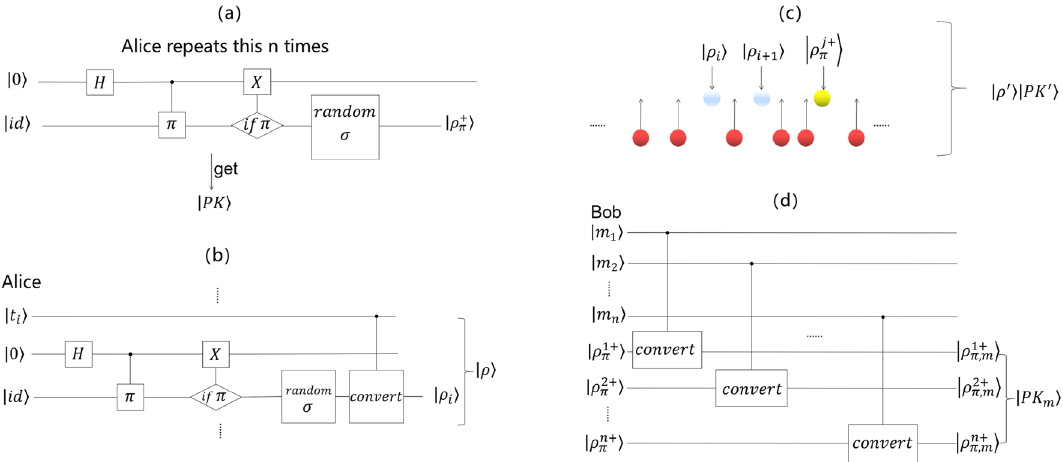
Figure 4. ( a ) Alice repeats the ρ + π ( n ) generation algorithm n times with her private key to obtain the public key, where the H, “if π ” and “random σ ” operations are the same as the operations in Fig. 3. ( b ) Alice uses this quantum circuit to obtain encrypted sequence perform the “convert” operation shown in Fig. 3c; if represent decoy particles, the white balls represent encrypted sequence PK key . Alice inserts decoy particles randomly into | � eavesdropping. ( d ) Bob uses this quantum circuit to obtain same as the “C-convert” operation in ( b ).